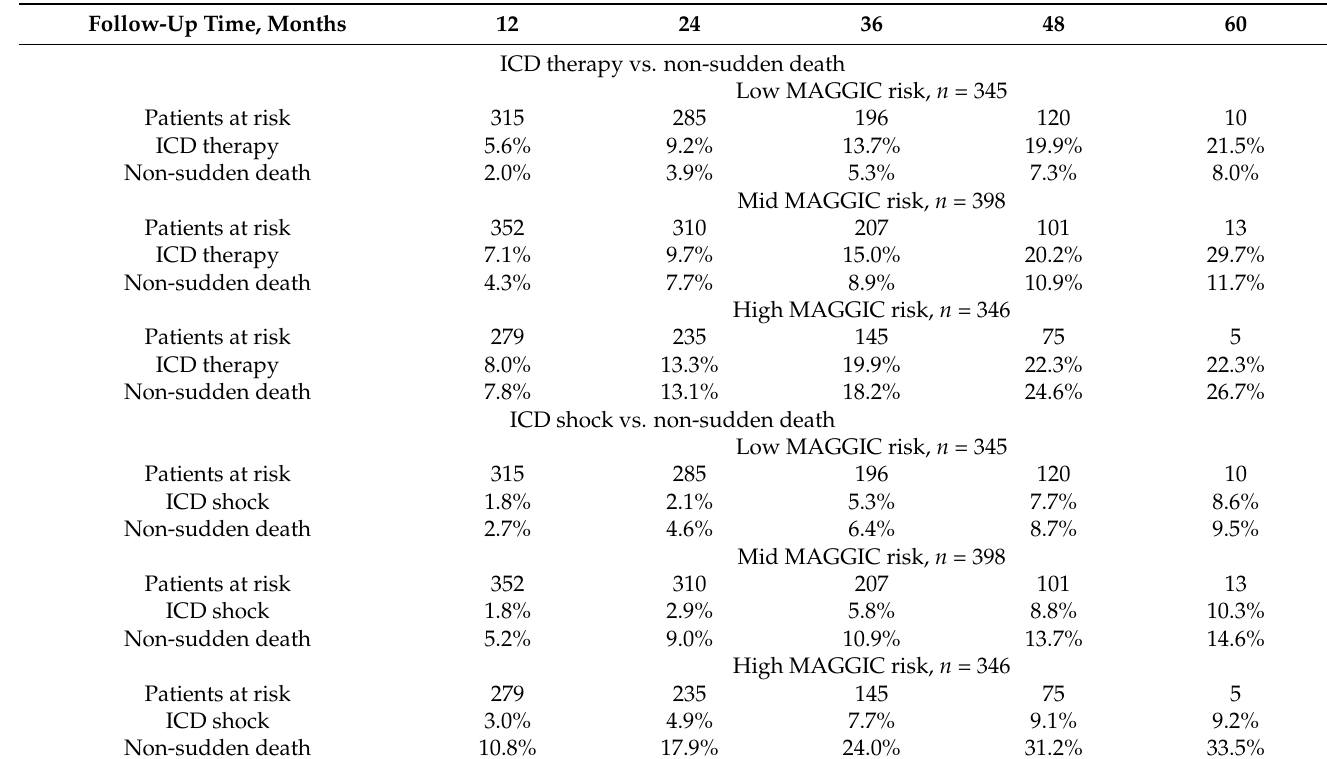
Figure 3. Cumulative incidence function estimate curves of competing causes of ICD therapy or shock and non-sudden death by tertiles of 3-year death probability estimated using the MAGGIC score. Table 2. Cumulative incidence estimates of outcomes of interest from competing causes according to tertiles of 3-year probability of death predicted by the MAGGIC